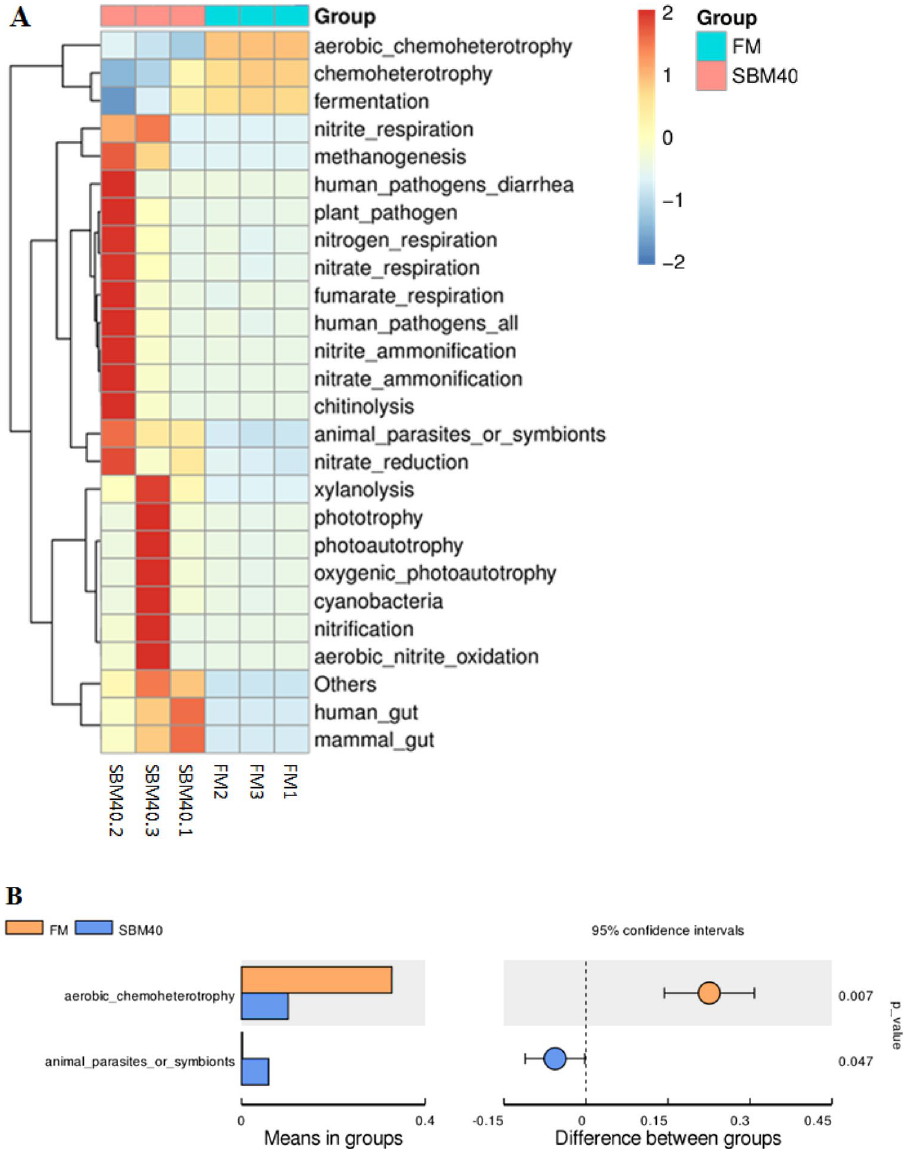
Figure 7. The intestinal microflora functional prediction of pearl gentian grouper fed by FM and SBM40 diets (n = 3). A, functional clustering heatmap by FAPROTAX; B, significance tests of functional difference analysis (n = 3).